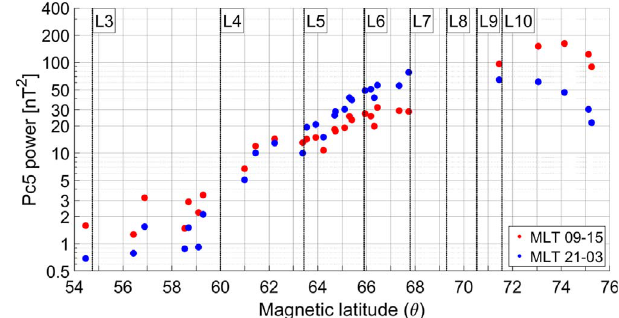
Fig. 5. Mean ULF power over years 1998 – 2008 for each IMAGE station separately for day (09 – 15 MLT) and night (21 – 03 MLT). The latitude of the respective L -shells (L3 – L10) are shown by vertical